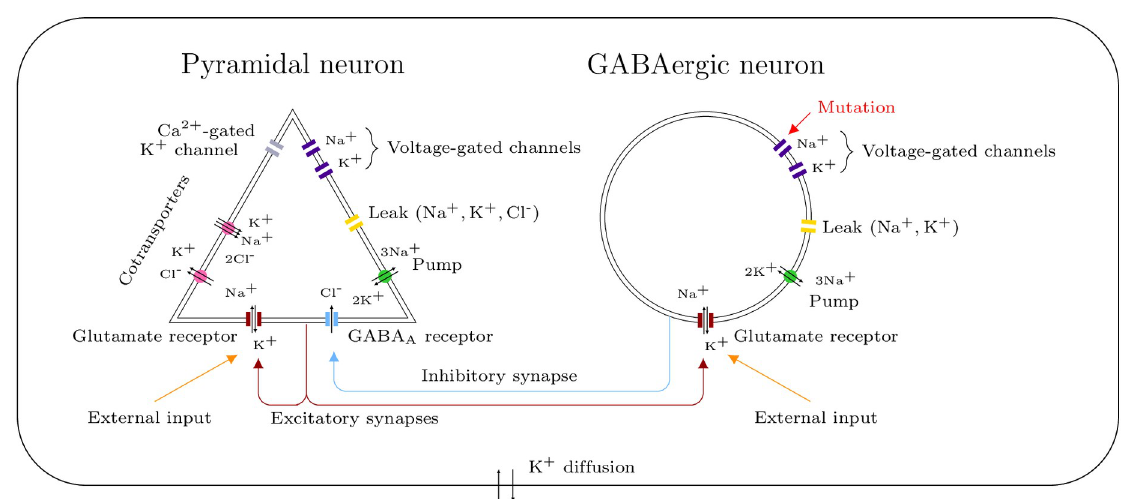
Fig 1. Schematic representation of the model. Consider a pair of interconnected neurons in a closed volume. We modeled a GABAergic synapse from the GABAergic neuron to the pyramidal one, a glutamatergic synapse from the pyramidal neuron to the GABAergic one and a glutamatergic autapse from the pyramidal neuron to itself. The ion transport mechanisms represented here generate transmembrane ionic currents, which modify the membrane potentials of the neurons and the ion concentrations in the different compartments. The diffusion of extracellular potassium takes into account both passive diffusion and glial buffering. We modeled external stimuli, which reflect the activity of the surrounding network or mimic experimental depolarizations, with glutamate inputs on the glutamatergic receptors. The implementation of Na V 1.1’s genetic mutations affects only the GABAergic neuron.